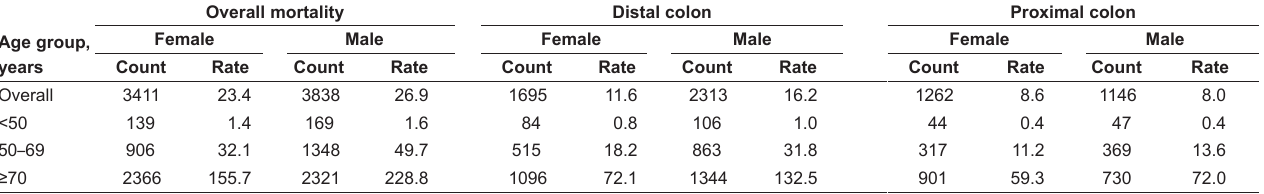
TABle 1 Colorectal cancer mortality counts and rates (per 100,000) according to site, sex and age, 1985 to 2009